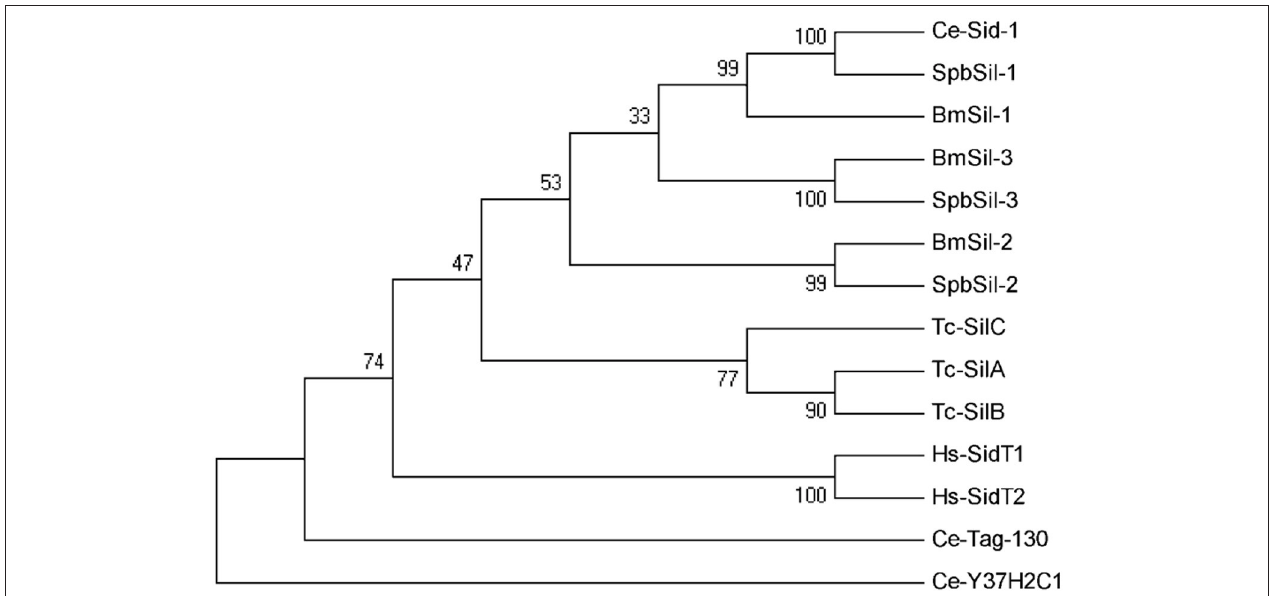
FIGURE 6 | Phylogenetic analysis of sid-1-like (sil) proteins. Neighbor-joining inferred phylogenetic relationships among insect sil proteins, including Ce-Sid-1 (AAL78657), Spbsil-1 (C77135), Bmsil-1 (BAF95805), Bmsil-2 (BAF95807), Spbsil-2 (C79601), Bmsil-3 (BAF95806), Spbsil-3 (C79695), Tc-silA (NP_001099012), Tc-silB (NP_ 001103253), Tc-silC (NP_ 001099128), Hs-SidT1 (EAW79633), Hs-SidT2 (EAW67296), Ce-Tag-130 (ABU75284), Cel-Y37H2C1CAA19499). Bootstrap values (1,000 replicates) are provided next to the branches. Ce, Caenorhabditis elegans , Bm, Bombyx mori ; Dm, Drosophila melanogaster ; Tc, Tribolium castaneum ; Hs, Homo sapiens ; Spb, soybean pod